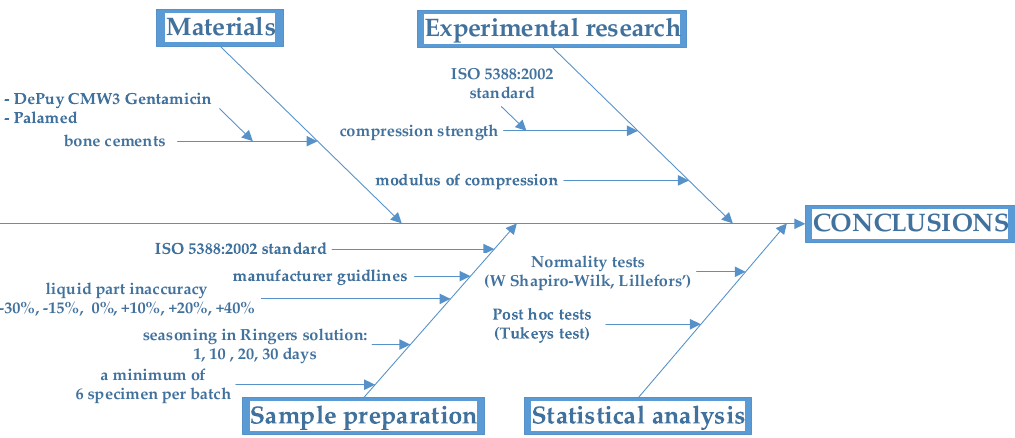
Figure 1. Research plan and main objectives of the analysis of results.